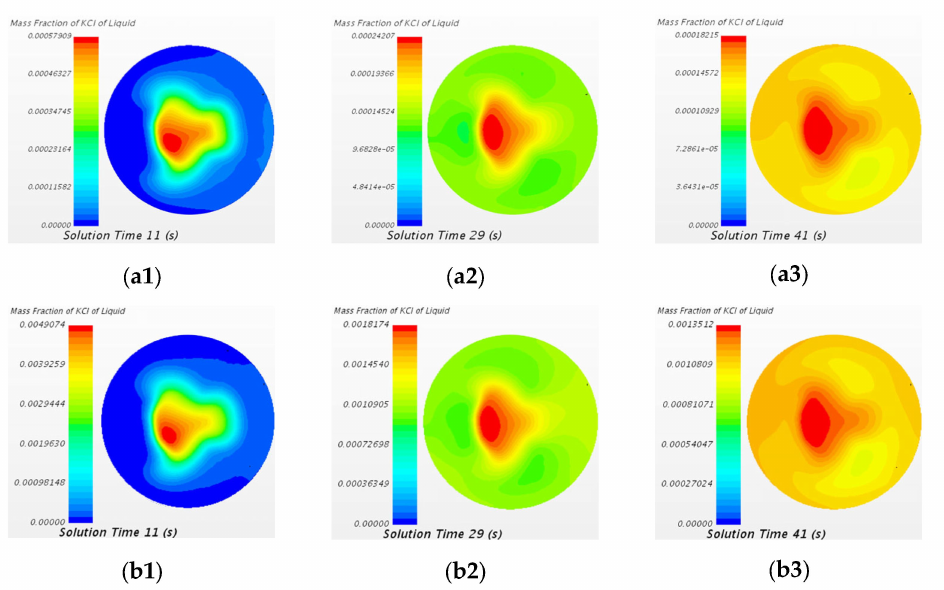
Figure 17. Comparison of mass fraction of KCl tracer of the case of 20 mL KCl tracer and the case of 150 mL KCl tracer at A2-A2 cross section at different time steps. ( a1 ) 20 mL 11 s, ( a2 ) 20 mL 29 s, ( a3 ) 20 mL 41 s, ( b1 ) 150 mL 11 s, ( b2 ) 150 mL 29 s, and ( b3 ) 150 mL 41 s.